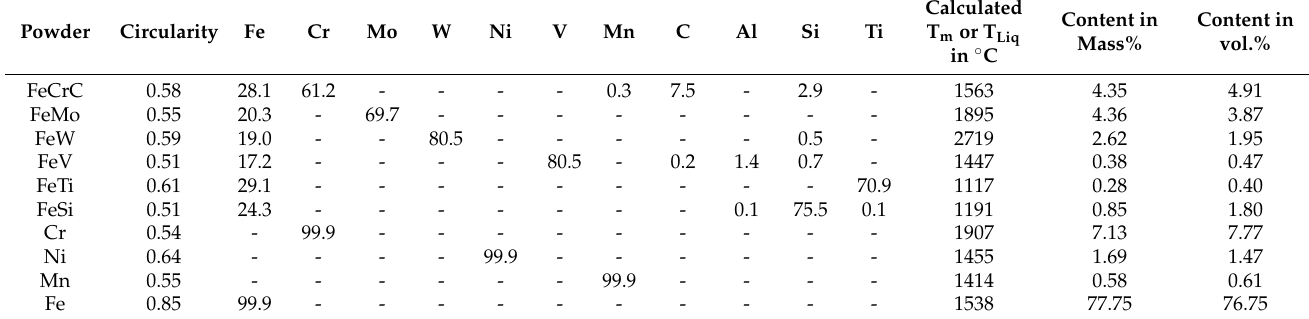
Table 2. Chemical composition of the used ferroalloy particles with a size of 20 to 63 µ m in mass%, calculated melting temperature T m , and solidus temperature T sol in ◦ C, and the percentage of used ferroalloys and pure